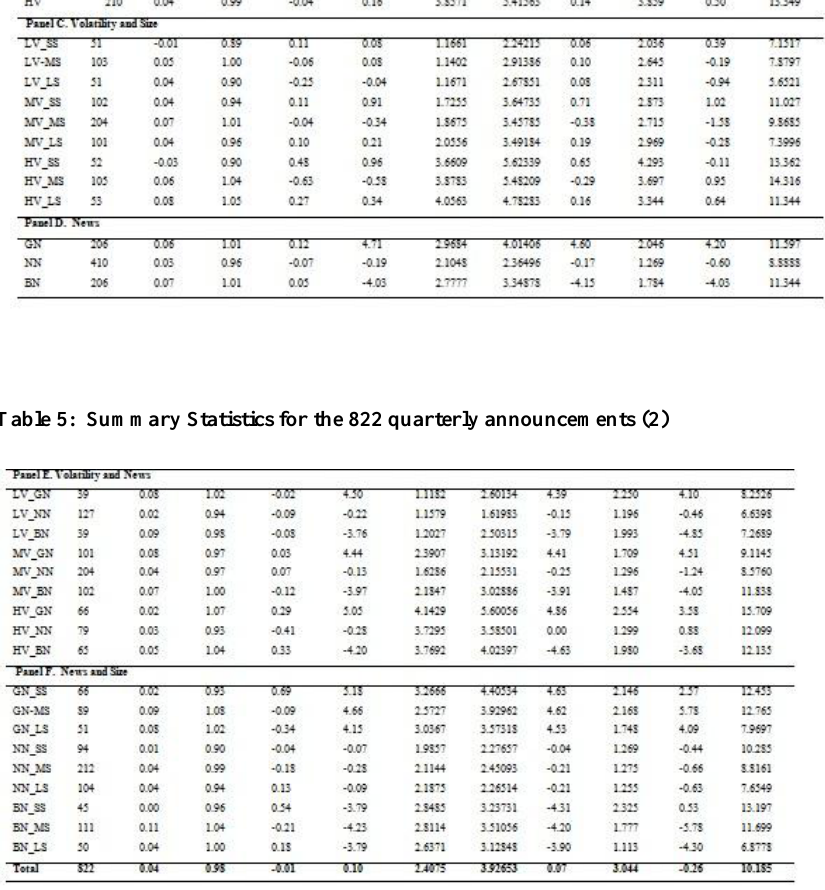
Note: Sample Statistics are shown for 822 quarterly announcement events of NSE-50 stocks during the period of 2005-2010. Abnormal Return (AR) is calculated by using daily adjusted closing return of the Market Model (OLS). Estimation window is considered as 100 days. Cumulative Abnormal Return (CAR) is calculated by accumulating AR over the event windows ( -10, 0, + 10 = 21 days). N =